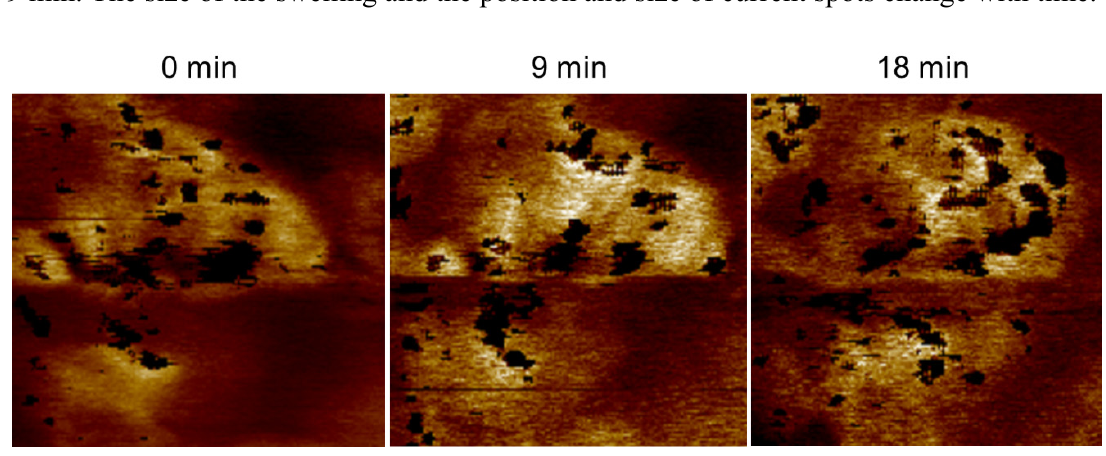
Figure 13. AFM stiffness and subtracted PeakForce-TUNA ® current image of the same area of activated Nafion ® 112 measured one after the other with an acquisition time of 9 min. The size of the swelling and the position and size of current spots change with